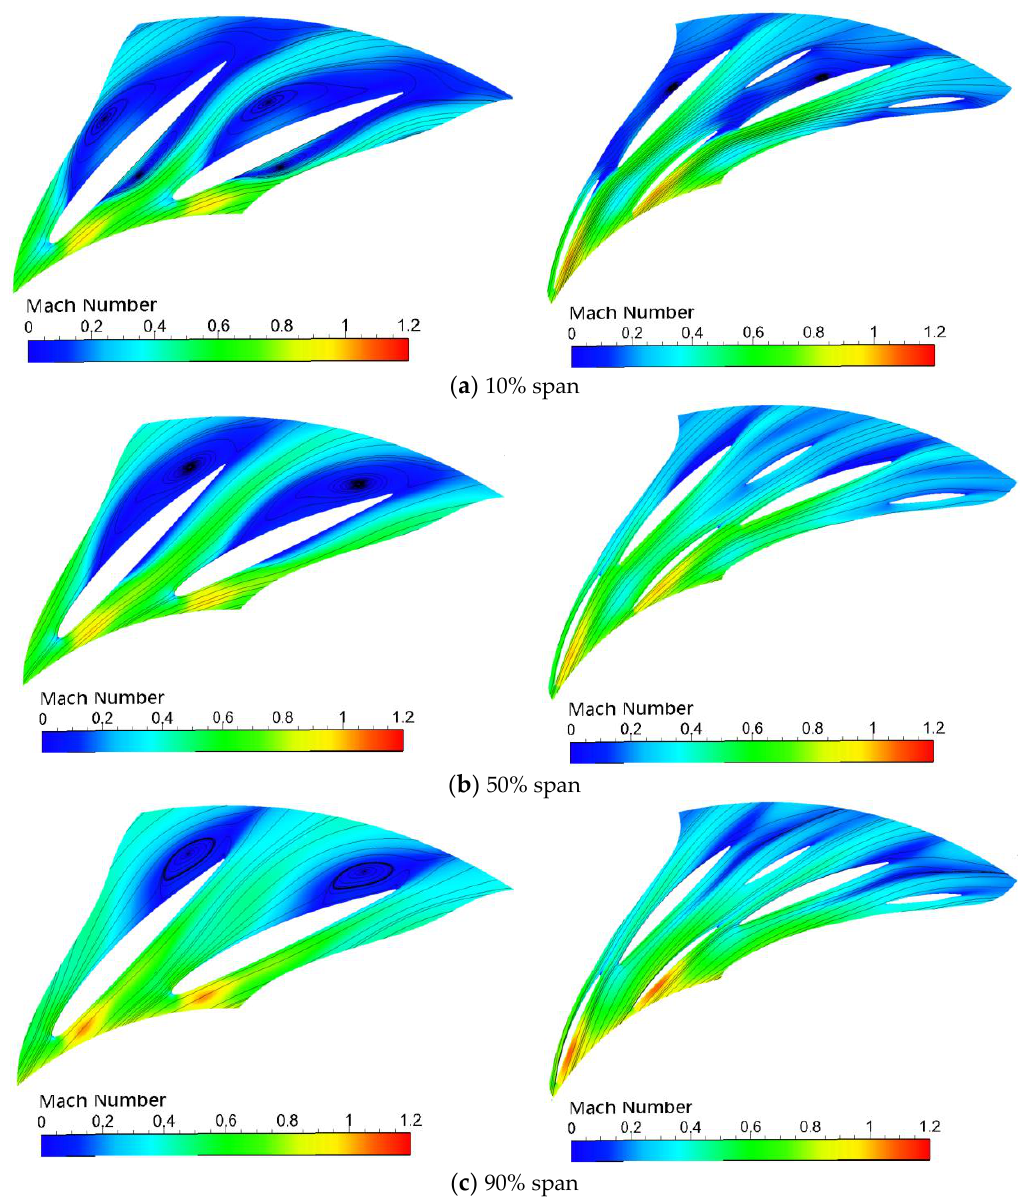
Figure 22. Mach number distribution at different spans of the original and optimized designs of the high-pressure-stage centrifugal compressor at 60% load.